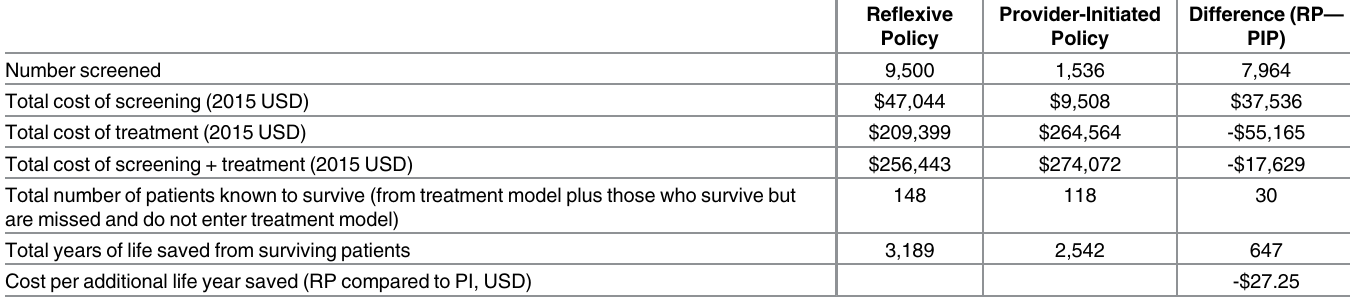
Table 4. Summary results for base case analysis (per 100,000 CD4 tests).